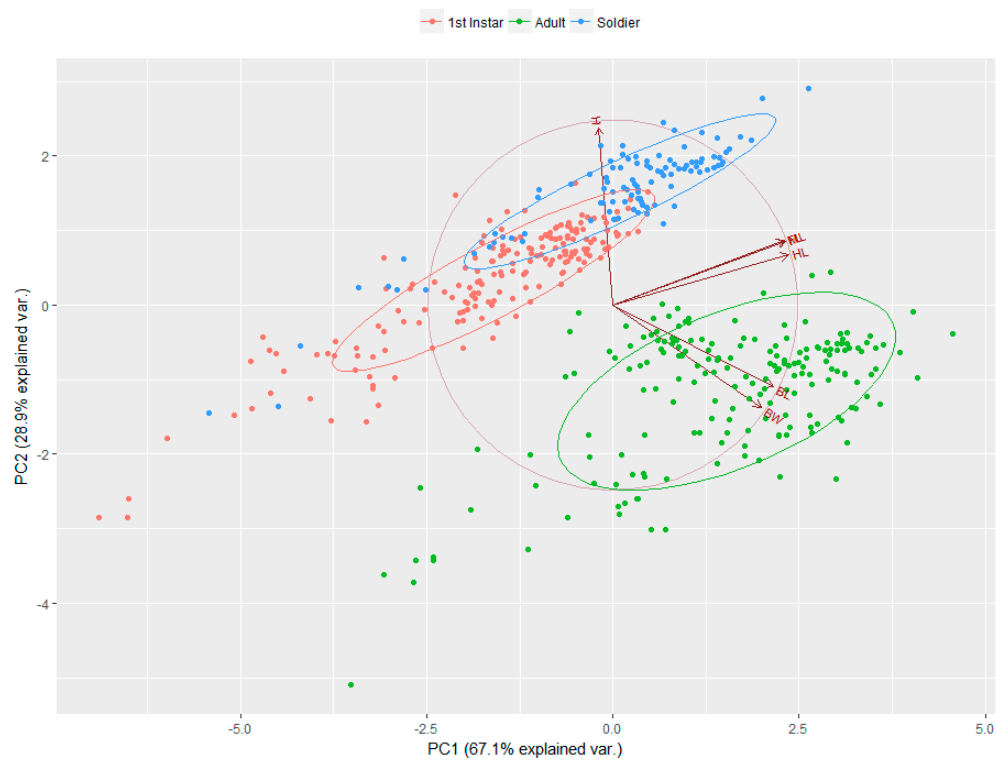
Figure 4. Principal component analysis (PCA) biplot based on the measurements of key morphological characters of P. bambucicola morphs. The three different colors (orange, green, and blue) indicate the first instars, adults, and soldiers, respectively. The x - and y -axes represent the principal component (PC) factor loadings, and the secondary x - and y -axes represent the PC factor scores. Principal component 1 (PC1, 67.1%) and principal component 2 (PC2, 28.9%) collectively explain 96% of the variation in the dataset.